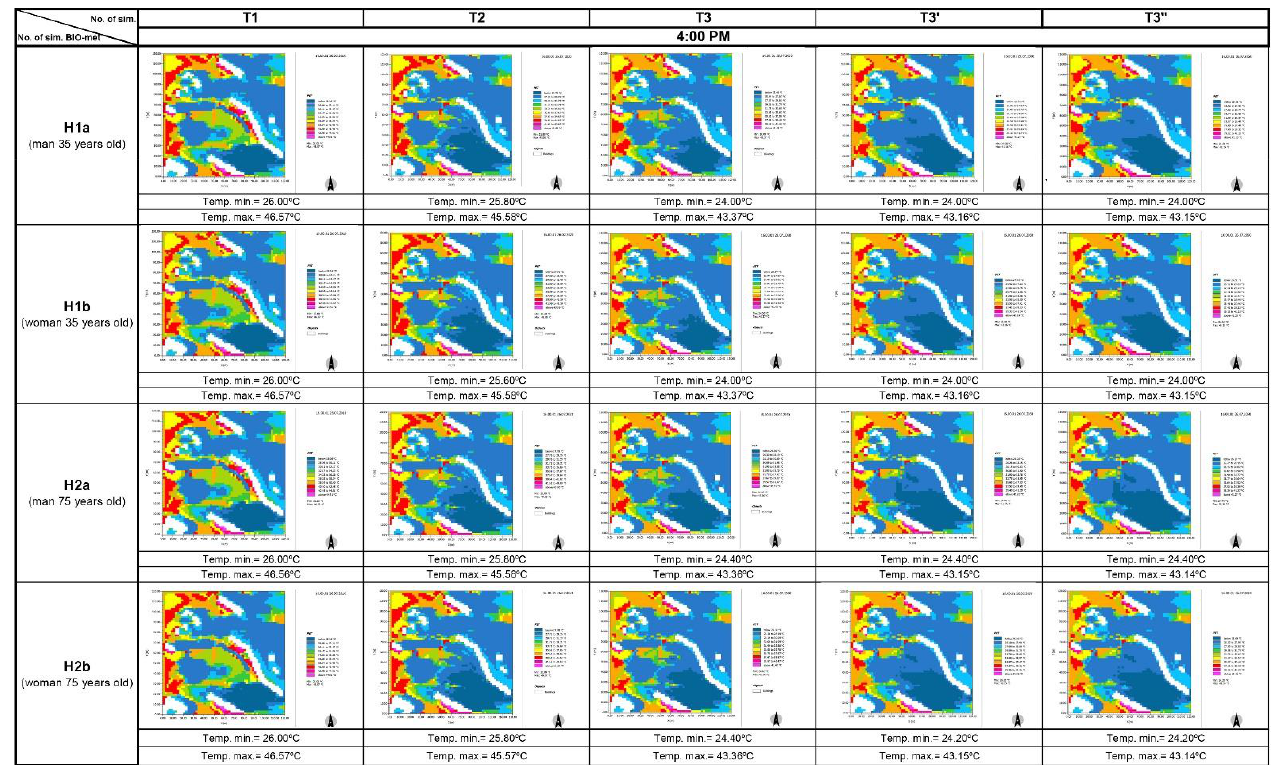
Figure 12. Summary of simulations for each group at 4:00 pm.